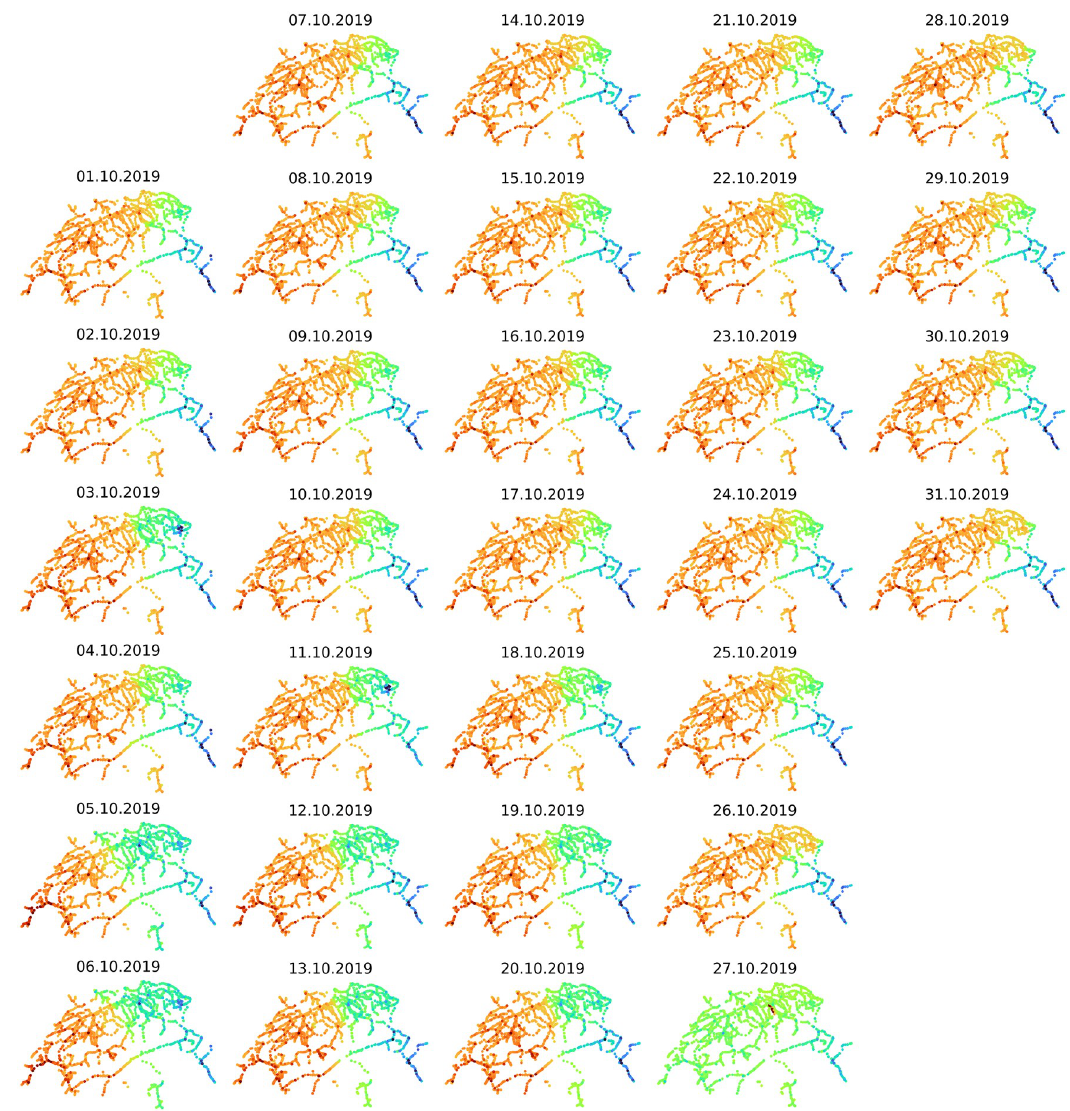
Fig 4. Spectral clustering in space and time (2 nd eigenvector). Spatiotemporal dynamics of the the Swiss railway’s weakly connected sub-communities. There is a stark, gradually attenuating shift in the spectral clusters during